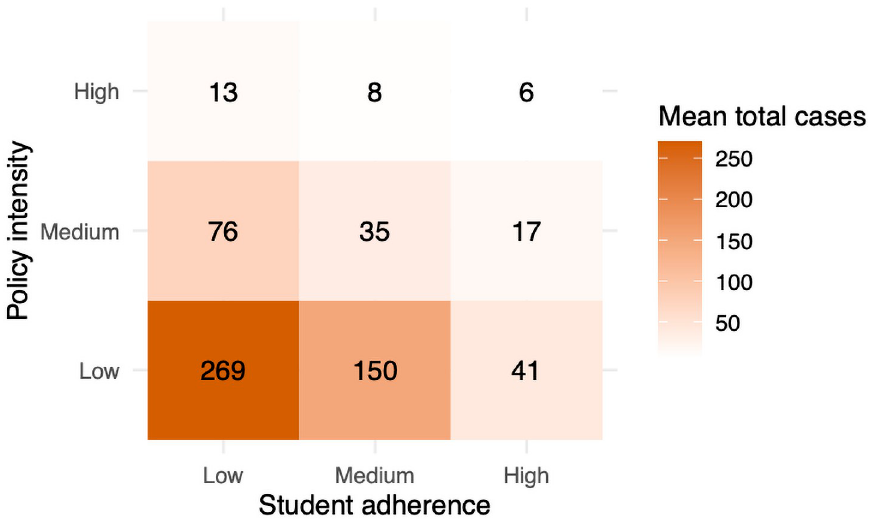
Fig 3. The total infection counts colored by size for different policy and adherence